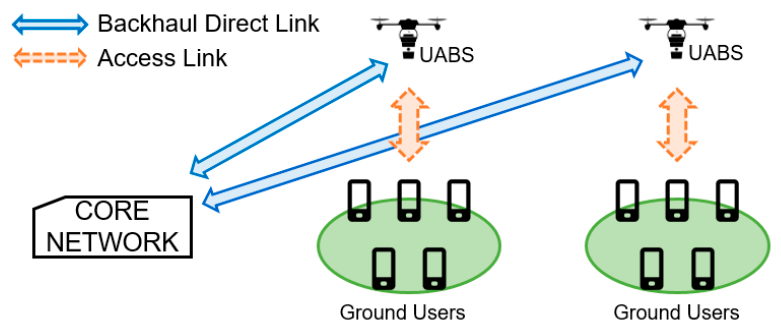
Figure 1. Direct backhaul scenario for an emergency network using unmanned aerial base stations (UABSs).